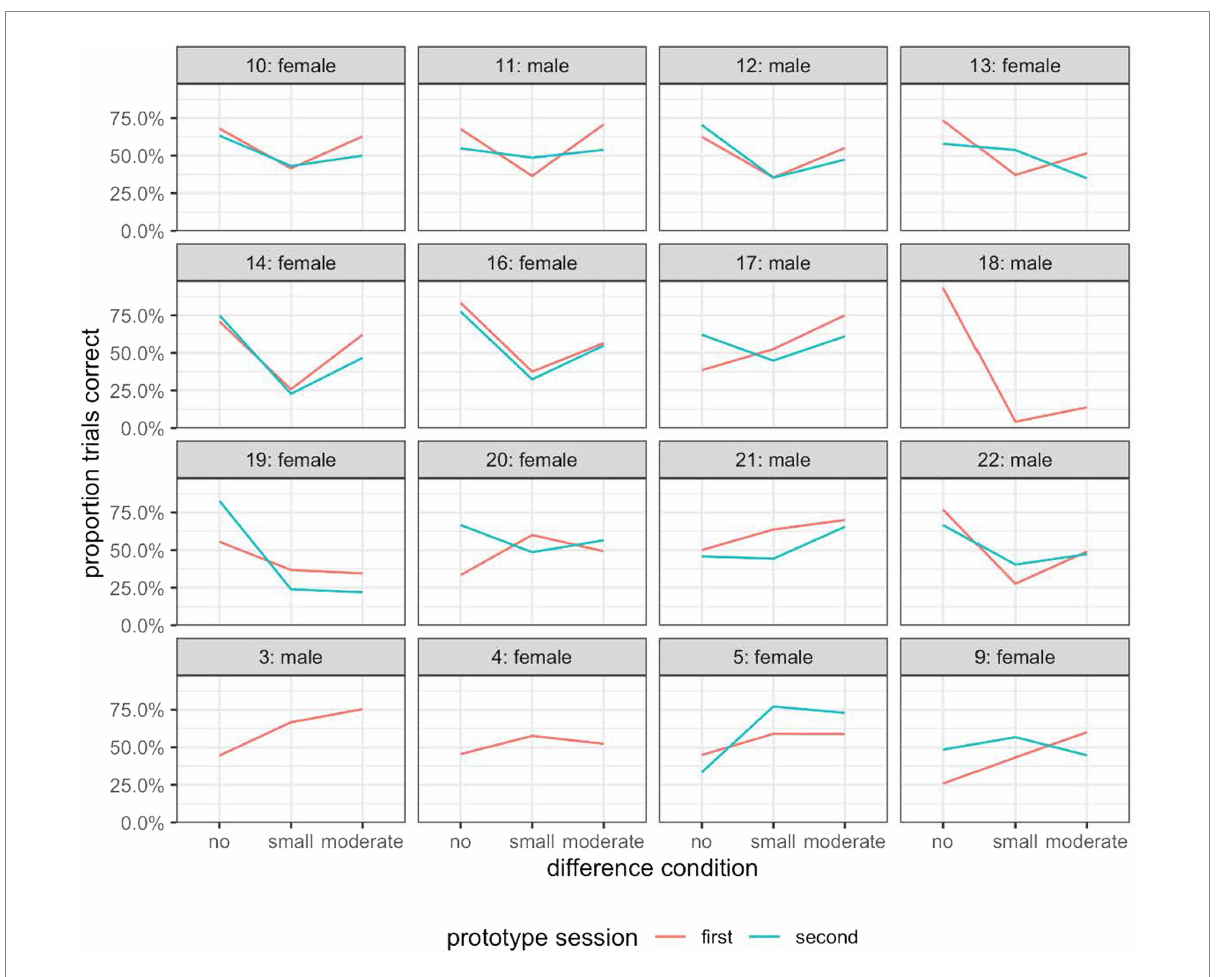
FIGURE 9 The percentage of trials with a correct response for each participant in the first and second half of the prototype-referent condition in Experiment